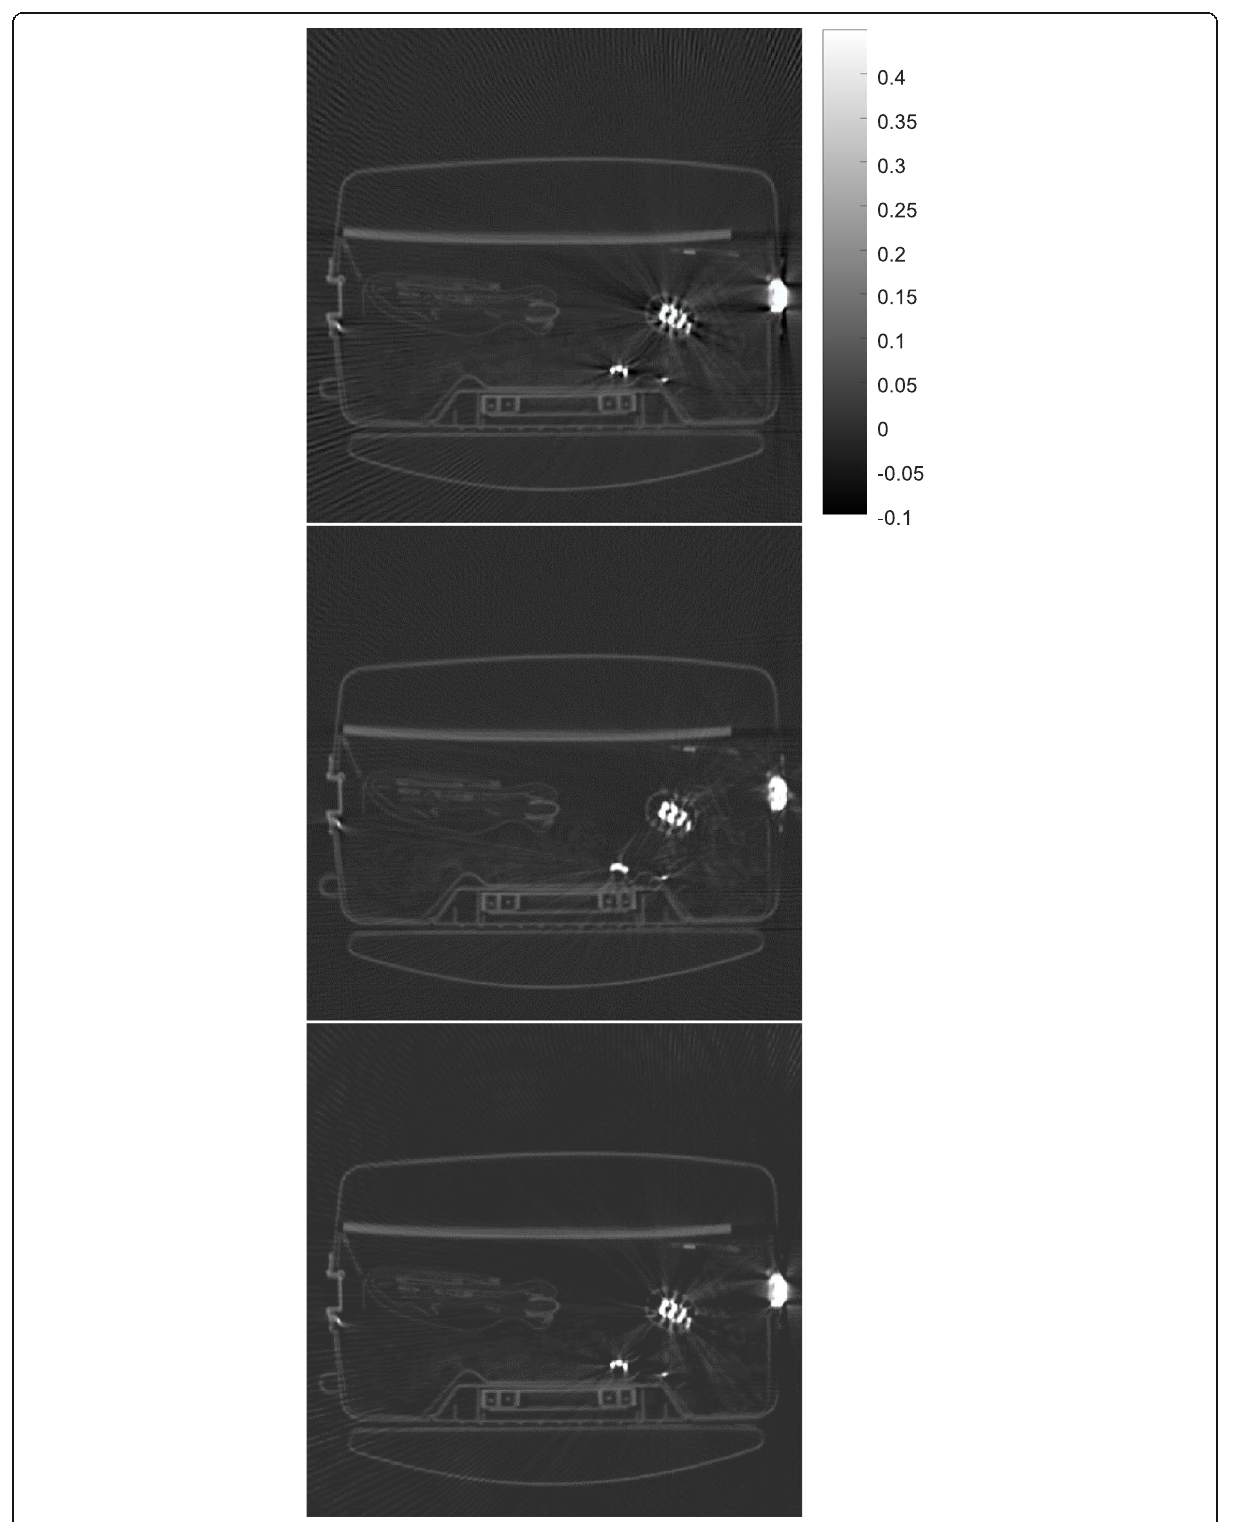
Fig. 5 CT image reconstruction of airport bag #5. Top: the raw FBP reconstruction; Middle: the reconstruction using the proposed algorithm; Bottom: the raw FBP reconstruction with all negative pixel values replaced by